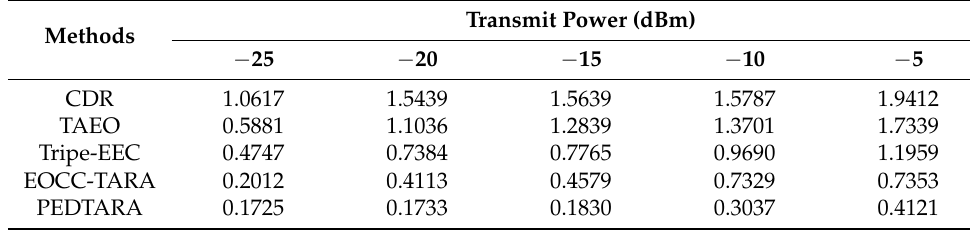
Table 5. Energy consumption (J).